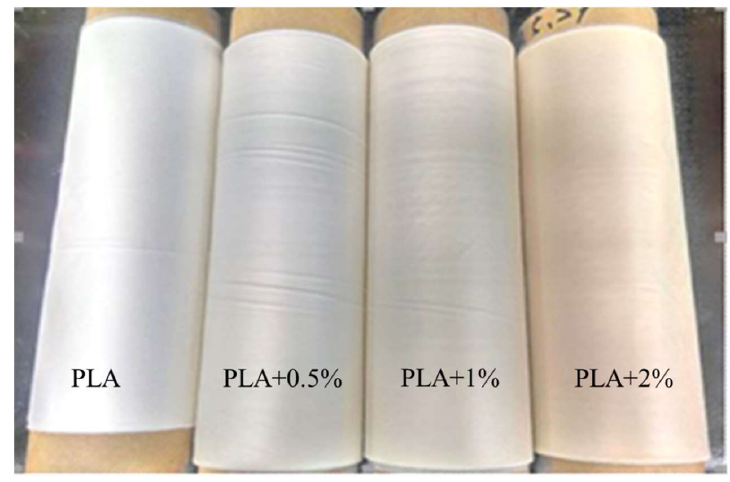
Figure 1. Appearance of the film rolls of PLA and PLA containing 0.5%, 1%, and 2% of chitosan. Table 1. Tensile strength, elongation at break, and tearing strength of PLA and Chitosan–PLA films. Tensile Strength (kgf/cm 2 Composition